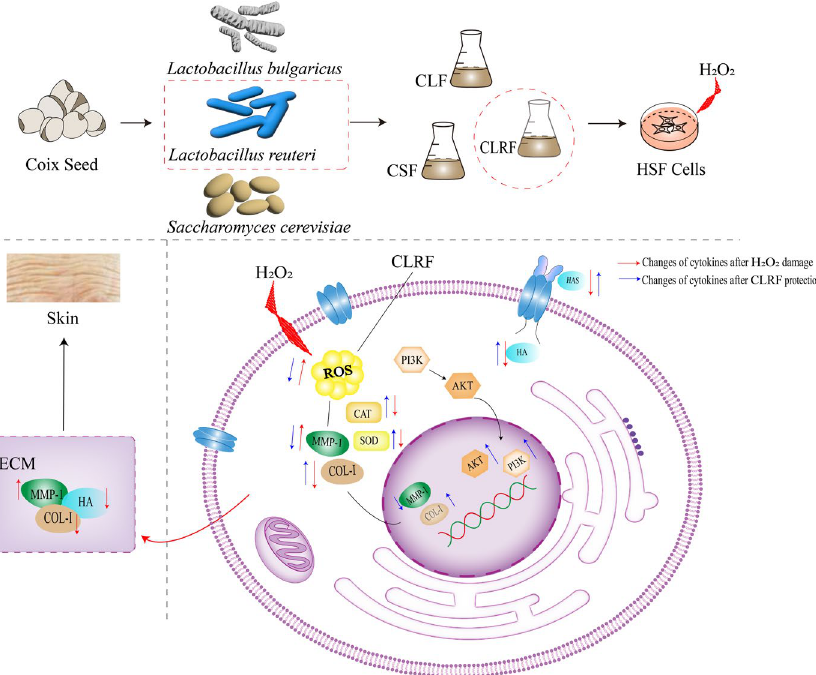
Figure 6. A schematic diagram showing the regulatory mechanisms of the protective effects of CLRF on skin fibroblasts damaged by H 2 O 2 . Coix seeds were fermented by three bacteria and finally CLRF was selected for cellular and molecular level investigation. After the protective treatment with CLRF, the HSF cells activated the expression of PI3K/AKT signaling pathway, inhibited the accumulation of ROS in the cells, enhanced the cellular antioxidant system, increased the content of COL-I and HA in the cytoplasmic matrix and decreased the content of MMP-1, protected the skin structure and slowed down the damage of H 2 O 2 on the HSF